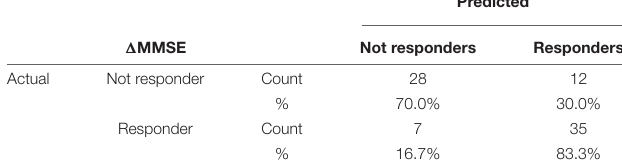
Confusion matrix summarizing the performance of the RF classification algorithm on the cognitive outcome. The column targets (Predicted Not responders/Responders) are predicted values by the RF and the row targets (Actual Not responders/Responders) are the actual values. Classification accuracy represents the proportion of the instances that were classified correctly (Actual Not responders and Predicted Not responders + Actual Responders and Predicted Responders/Total sample). MMSE, Mini-Mental State